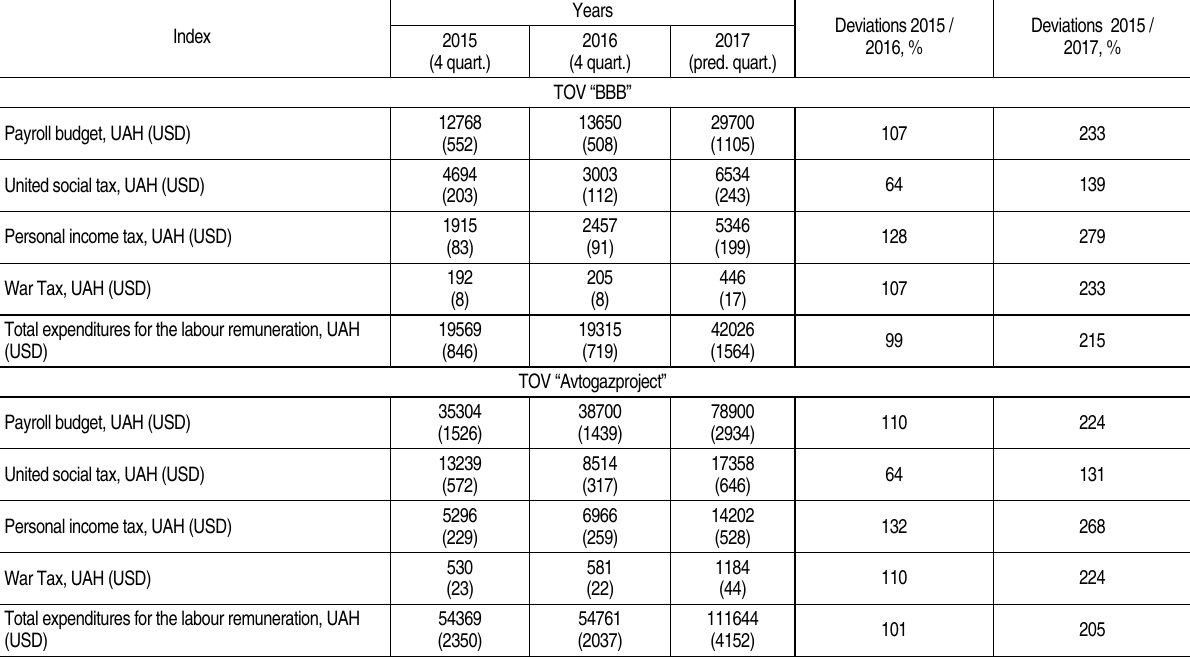
Table 2. Comparative analysis of the payroll budget and social contributions in the activity of TOV “BBB”, TOV “Avtogazproject”, TOV “LMG” (developed by the